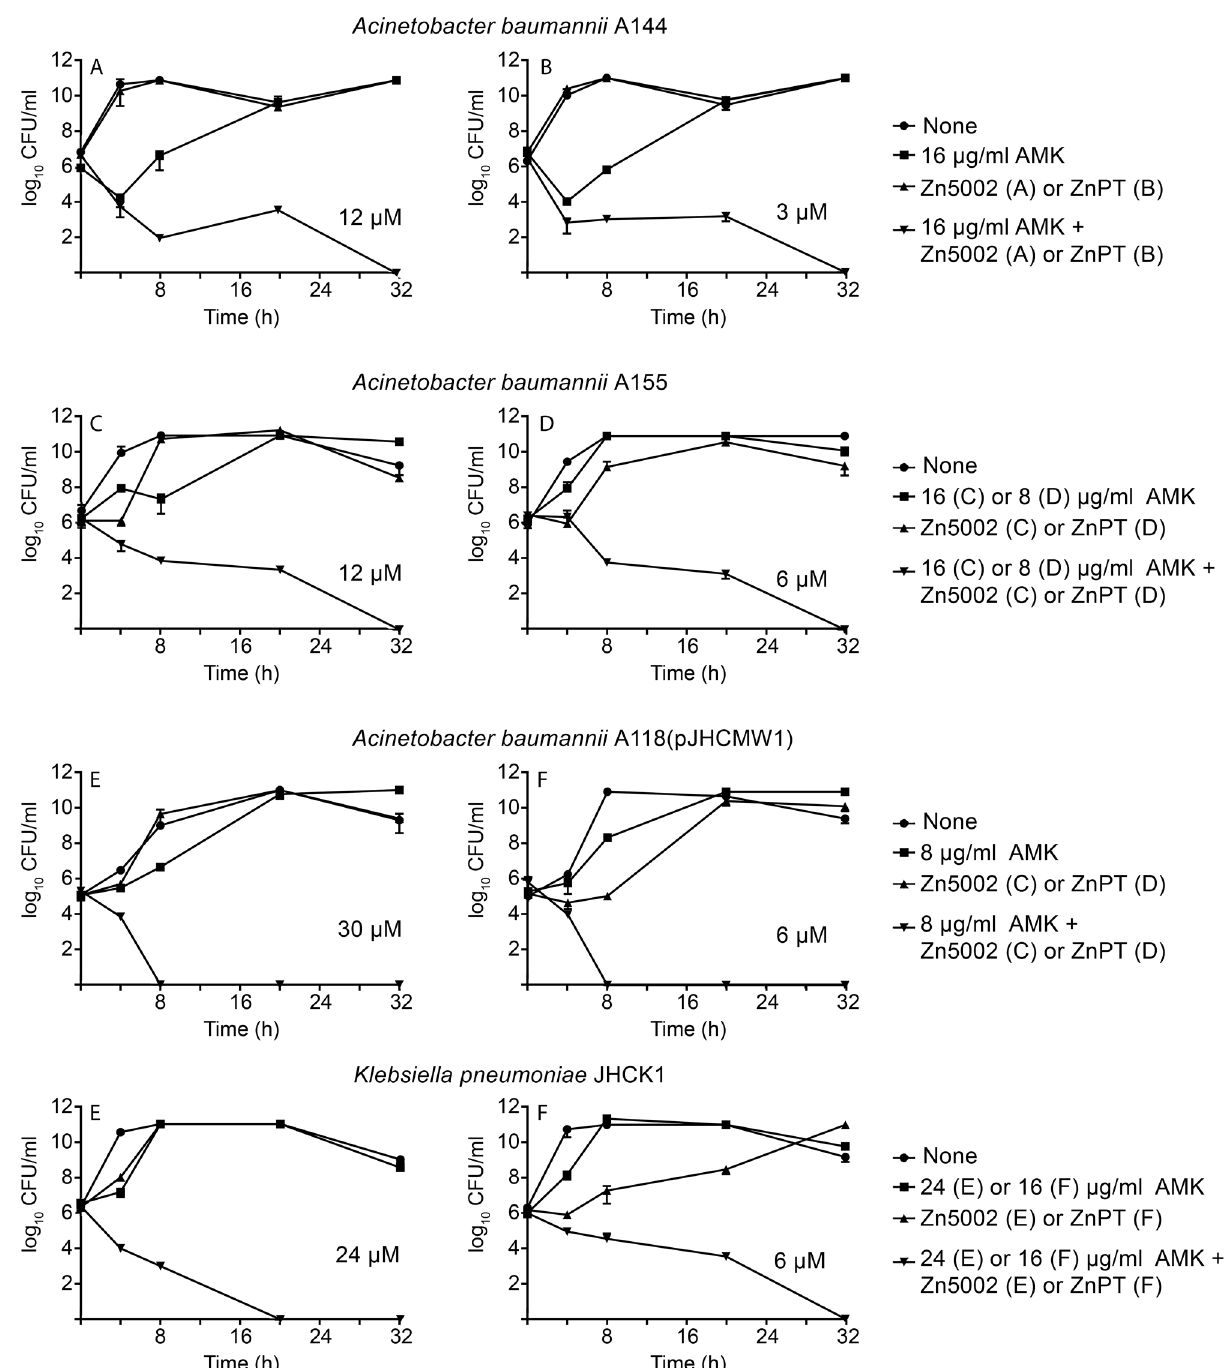
Figure 3. Time-kill assay curves for amikacin in the presence of Zn5002 and ZnPT. A . baumannii A155, A144, A118(pJHCMW1), or K. pneumoniae JHCK1 were cultured in 100 μl Mueller–Hinton containing 0.5% DMSO until they reach 10 6 CFU/ml. At this moment the cultures were supplemented with the additions indicated to the right of each panel, the cultures were continued at 37 °C with shaking and samples were removed periodically to determine CFU/ml. AMK, from strain to strain. This characteristic can be due to aac(6 ′ )-Ib gene dosage or other mechanisms or properties that may help the resistance, such as efflux pumps or low permeability. Inspection of the results indicates that the active concentrations of Zn5002 were consistently higher than those of ZnPT, suggesting that a reduction in activity accompanied the gain in solubility in aqueous solutions. However, the fact that a highly water-soluble derivative of ZnPT conserved the activity indicates that further research will permit us to design other robust